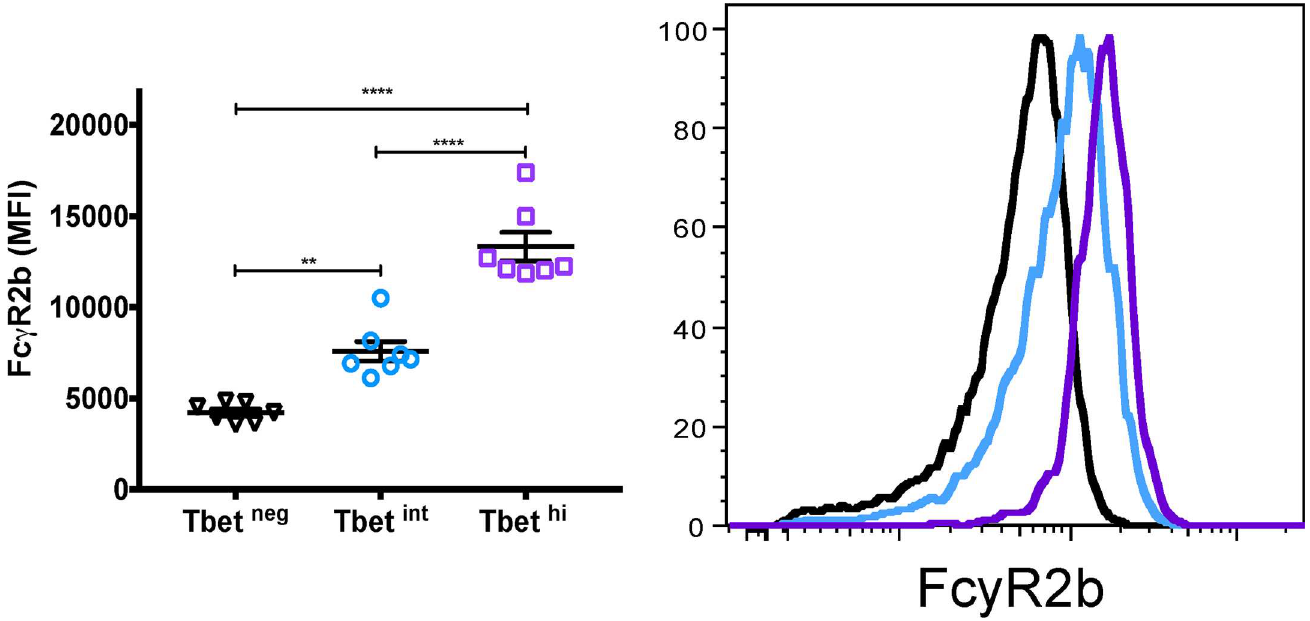
Fig 4. T-bet hi B cells of malaria-exposed children upregulate the inhibitory receptorFcyR2B. Ex vivo expressionof FcyR2B on total CD19 + B cells stratified by level of T-bet expressionin Malian children (n = 7; representative subject, right). p values determinedby pairedStudent’s t test with Bonferroni corrections for multiplecomparisons where appropriate. **** P < 0.0001, *** P < 0.001, ** P < 0.01, * P < 0.05,ns = not significant.